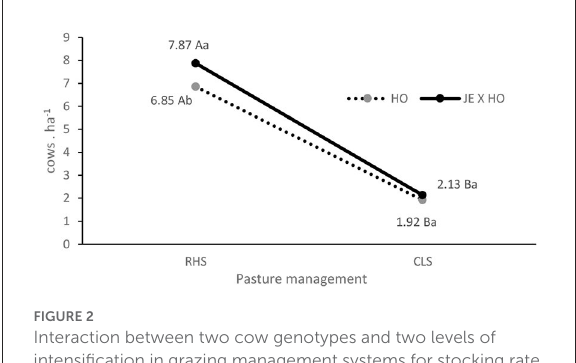
FIGURE2 Interaction between two cow genotypes and two levels of intensification in grazing management systems for stocking rate. HO, Holstein cows; JE x HO, Jersey and Holstein cows crossbred; RHS, intensive—rotational grazing system, irrigated pasture with high stocking rate; CLS, extensive—continuous grazing system with low stocking rate. a − b ; A − B , means followed by different uppercase letters to pasture and lowercase to genotype are significantly different ( p ≤